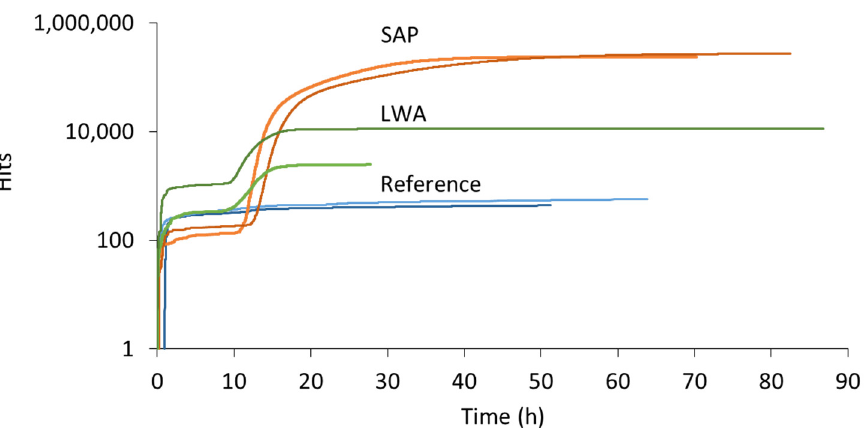
Figure 6. Cumulative hits vs. curing time received during AE monitoring of reference (= blue), SAP (=orange) and LWA (=green) mortar.